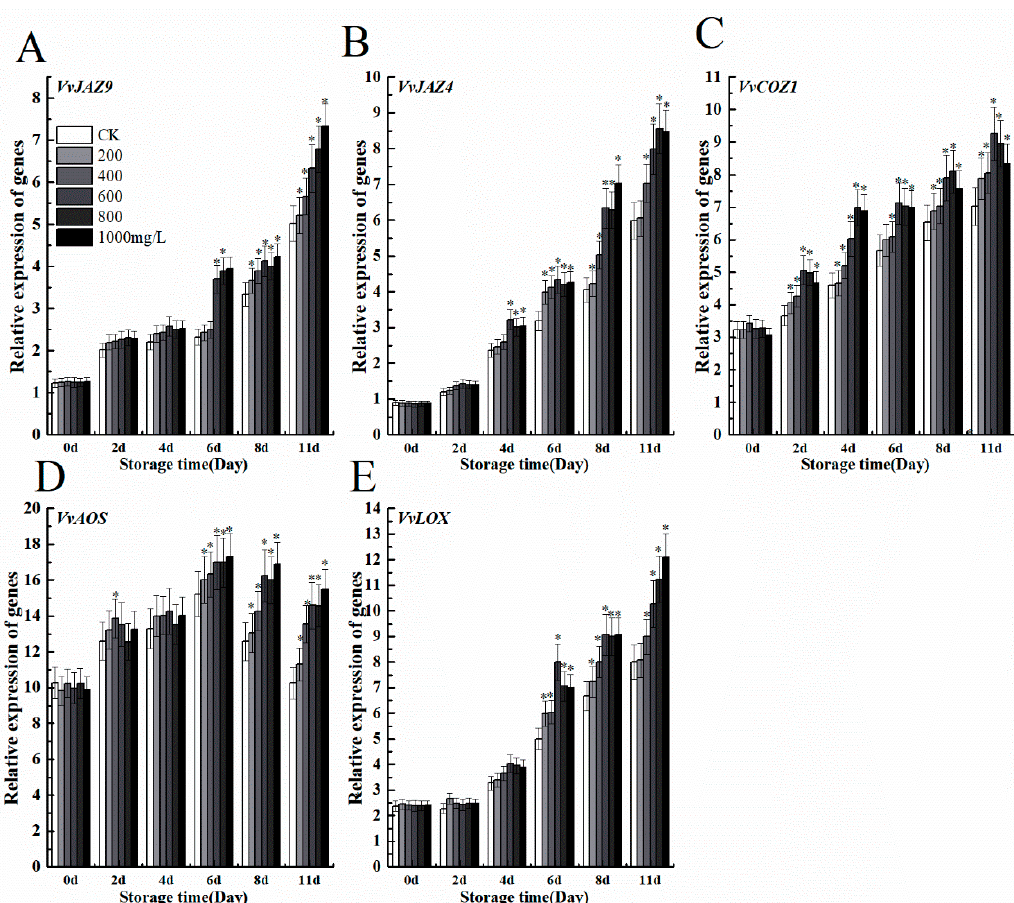
Figure 8. Effect of ethephon on JA-related genes expression in grape. JA metabolism-related gene expression levels of ( A ) VvJAZ9 , ( B ) VvJAZ4 , ( C ) VvCOZ1 , ( D ) VvAOS , and ( E ) VvLOX . Ethephon was used in different concentrations (200, 400, 600, 800, and 1000 mg/L) and in time course experiments (2, 4, 6, 8, and 11 days). Values are means ± SD of five biological replicates. * Significant differences compared with the control (water-treated fruits) sample at p < 0.05, using Student’s test.